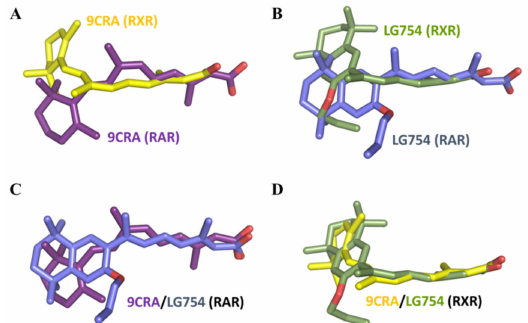
Figure 9. Conformation of the bound LG754 in RAR β and RXR α . ( A ) superposition of 9CRA as seen in the LBP of RXR α (PDB code 1fby) [70] and RAR β (PDB code 1xdk) [71]; ( B ) superposition of LG754 as seen in the LBP of RXR α (PDB code 6sti) and RAR β (PDB code 6ssq); ( C ) superposition of LG754 and 9CRA as seen in the LBP of RAR β (PDB code 6ssq) and of 9CRA as seen in the LBP of RAR β (PDB code 1xdk) [71]; ( D ) superposition of LG754 as seen in the LBP of RXR α (PDB code 6sti) and of 9CRA as seen in the LBP of RXR α (PDB code 1fby)